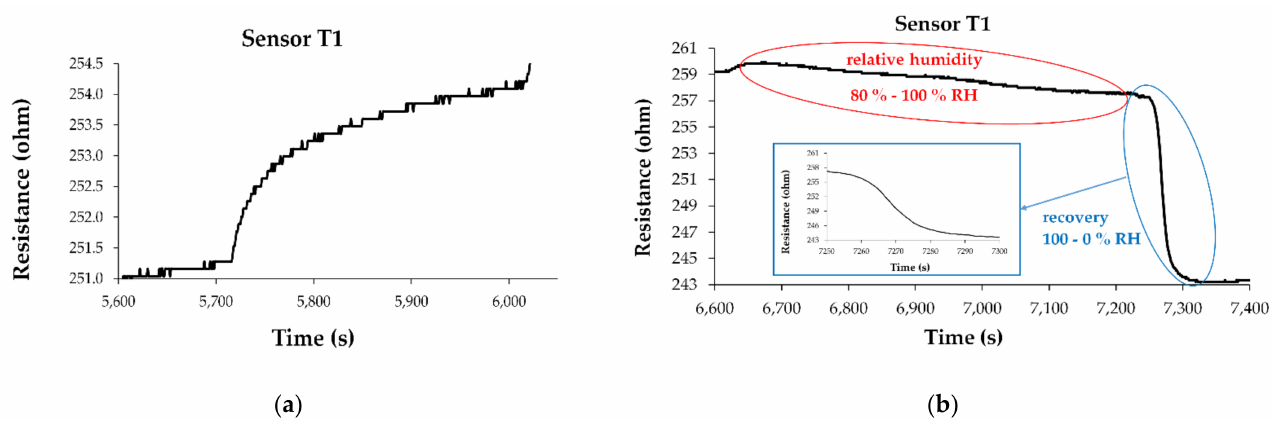
Figure 14. Response and recovery times of the T1 humidity sensors with sensing coatings kept at room temperature, where ( a ) is the response time and ( b ) is the recovery time for sensor T1. Response time was measured for the case when relative humidity is increased from 40% to 50%, while the recovery time was measured from 100% to 0% RH (clean dry